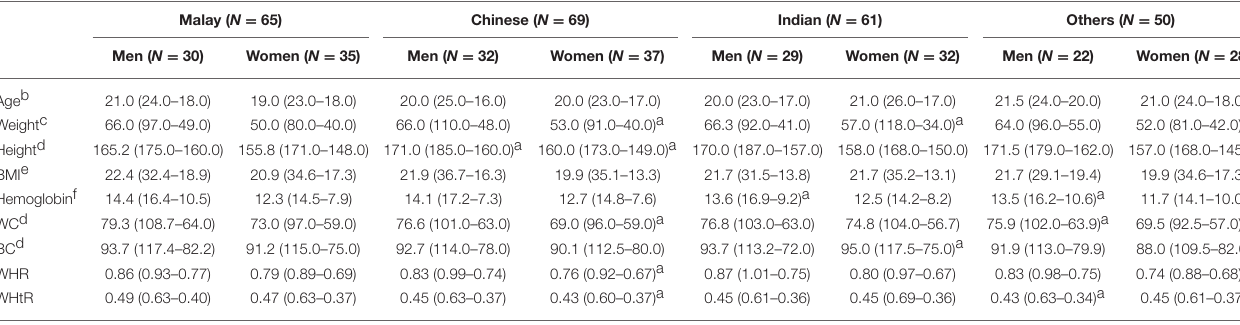
TABLE 4 | Comparison of various parameters between men and women of different ethnic